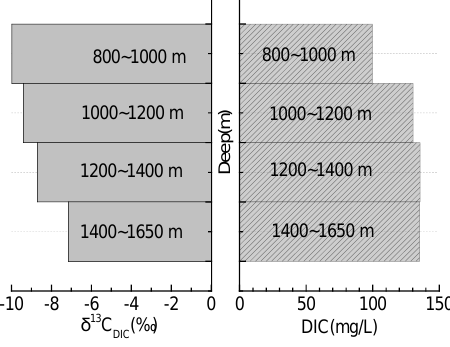
Figure 3. Dissolved inorganic carbon (DIC) and δ 13 C DIC of geothermal water at different burial depths. In sum, δ D, δ 18 O, d value, DIC, and δ 13 C DIC all exhibit regular changes with increasing depth in the vertical direction. These changes include δ D and δ 18 O increasing gradually, d value decreasing, and DIC and δ 13 C DIC increasing gradually. Thus, δ D, δ 18 O, d value, DIC, and δ 13 C DIC can be used to indicate the burial characteristics of geothermal water in the city of Kaifeng. In the horizontal direction, variation in δ D, δ 18 O, and δ 13 C DIC are relatively slight, while variation in d values and DIC are relatively large along the direction of geothermal water flow. Thus, d values and DIC can be used to indicate the migration of geothermal water in the city of Kaifeng.